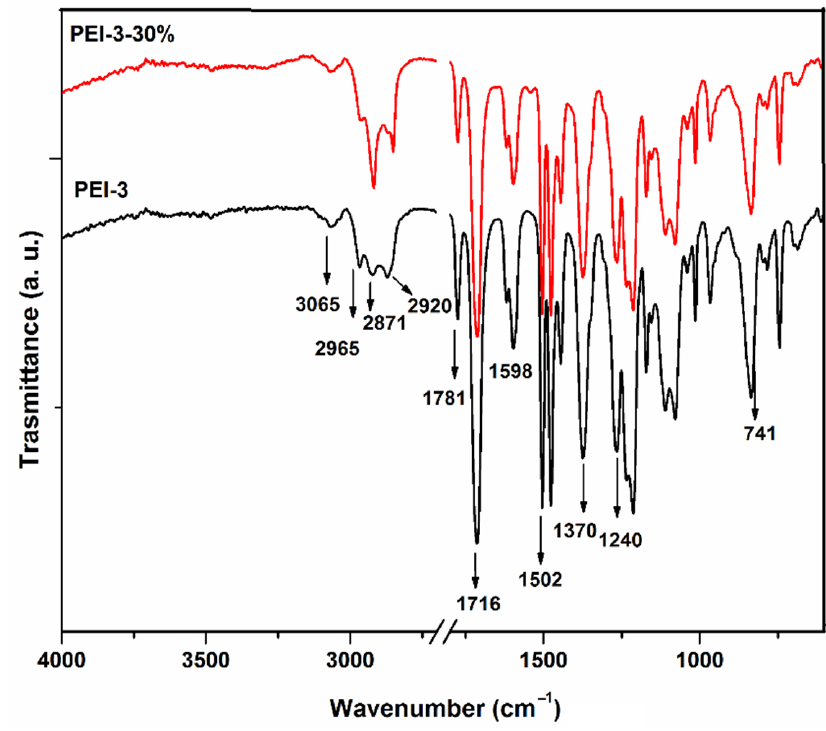
Figure 1. FTIR spectra of PEI ‐ 3 and PEI ‐ 3 - 30%.